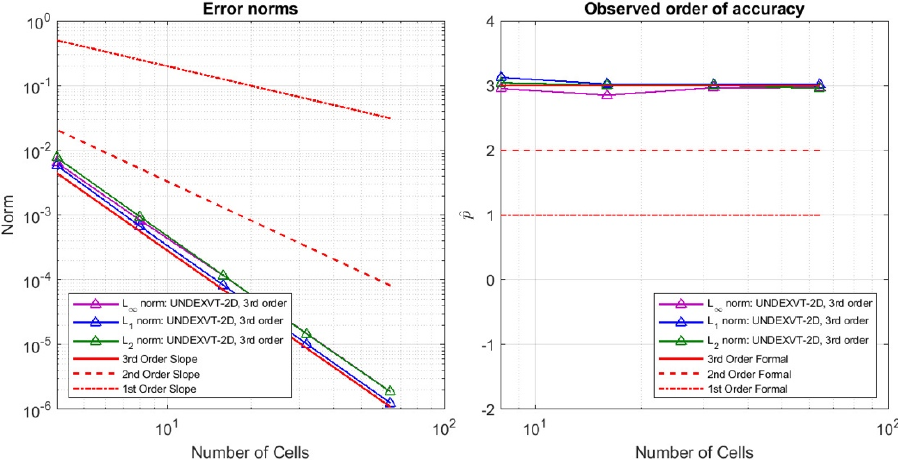
Figure 5. Observed order of accuracy of the 2D third-order solver ( left : error norm; right : observed order of accuracy). Table 4. Observed order of accuracy of the 2D third-order